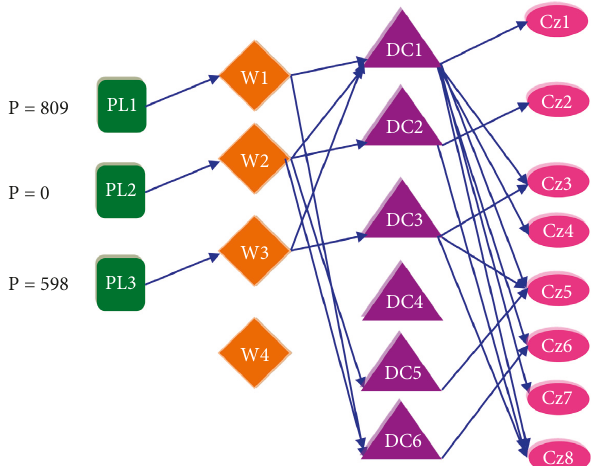
Figure 3: Network structure and produced products for the de- veloped model. Table 3: Total products transported from plants to warehouses. Developed